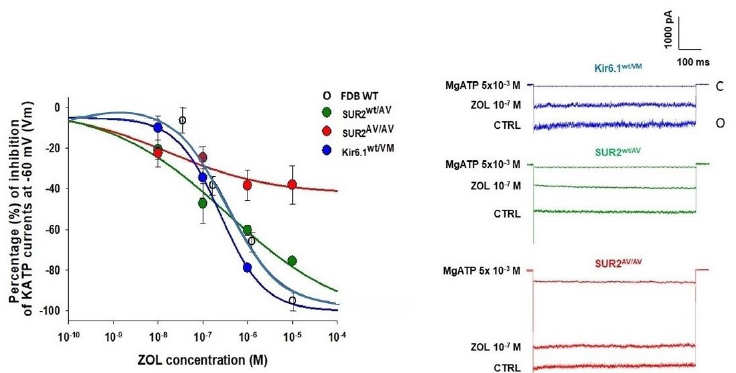
Figure 1. Concentration–response relationships of zoledronic acid concentrations vs. KATP current percentage inhibitions in the Flexor digitorum brevis (FDB) skeletal muscle fibers from different SUR2 hetero- and homozygous CS mice and relative KATP channel current traces. C—closed current level, O—open inward current level. The experiments were performed in excised macropatches from isolated fibers in the presence of high KCl on both sides of the membrane patches during voltage steps going from 0 mV to − 60 mV (Vm). The drug solution was applied on the intracellular side of the patches. Zoledronic acid fully reduced KATP channel currents in either heterozygous SUR2 wt/AV and Kir6.1 wt/V65M but not in homozygous SUR2 A478V/A478V muscle fibers. Each point of the concentration–response curves was obtained on 11–19